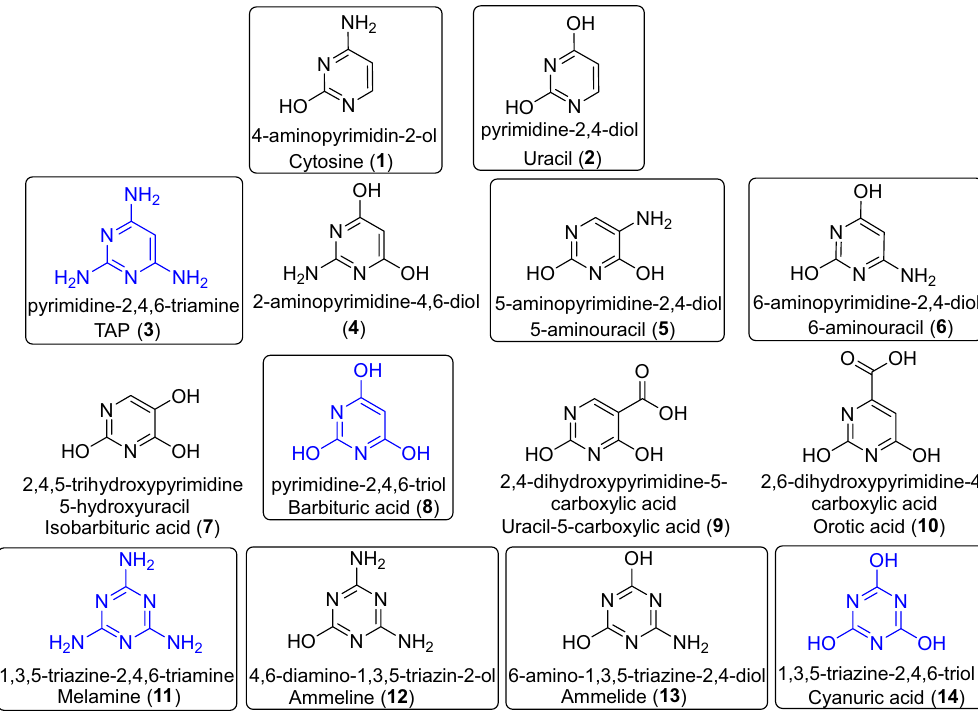
Figure 1. Pyrimidines and triazines taken into account in the present study. All these bases, except for compounds ( 9 ) and ( 10 ) , are part of a reasonable chemical space considered to contain rational eligible proto- nucleobases, with a total of 91 N-heterocycles 5 . The N-heterocycles in boxes may be forward compatible for pairing with an extant nucleobase in a Watson–Crick-like base pair. In addition, the compounds marked in blue can undergo assemblages with at least one other N-heterocycle of the aforementioned chemical space as monomers in water. Moreover, bases ( 3 ), ( 8 ) and ( 11 ) produce nucleosides with sugars 4,5 . Cytosine ( 1 ) and uracil ( 2 ) are extant RNA nucleobases. Compound ( 7 ) is a possible deamination product of ( 5 ), and ( 9 ) can be the deamination product of ( 7 ). In the same way, ( 8 ) is a possible deamination product of ( 3 ) and ( 6 ), and ( 10 ) can be the deamination product of ( 8 ) . Compound ( 4 ) is an isomer of both ( 5 ) and ( 6 ), and ( 4 ) can also be a deamination product of ( 3 ). In this scheme, only the tautomeric forms identified by GC–MS after derivatization with BSTFA are shown to obtain their corresponding TMS derivatives (for details, please see Supplementary Information, Figures S1–S14). The IUPAC nomenclature and the traditional and/or acronym names are